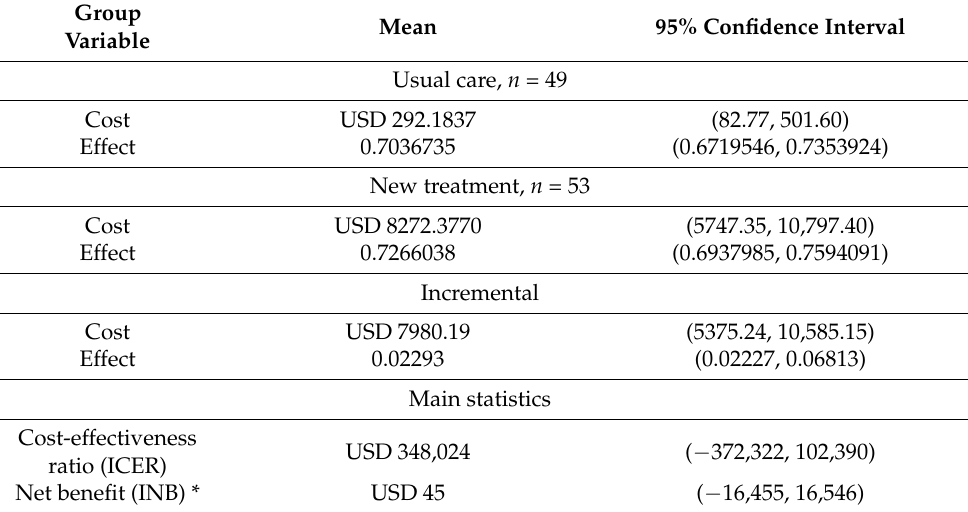
Table 1. Estimates of Cost, Effect, and Cost Effectiveness from a hypothetical